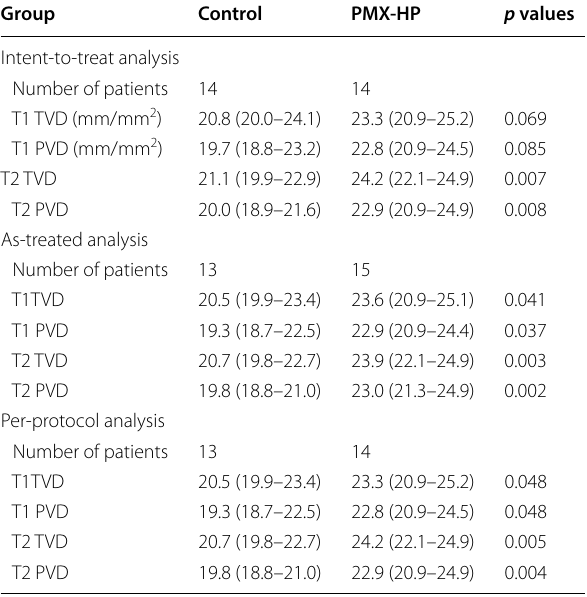
Table 3 Different analyses of total vessel density (TVD) and perfused vessel density